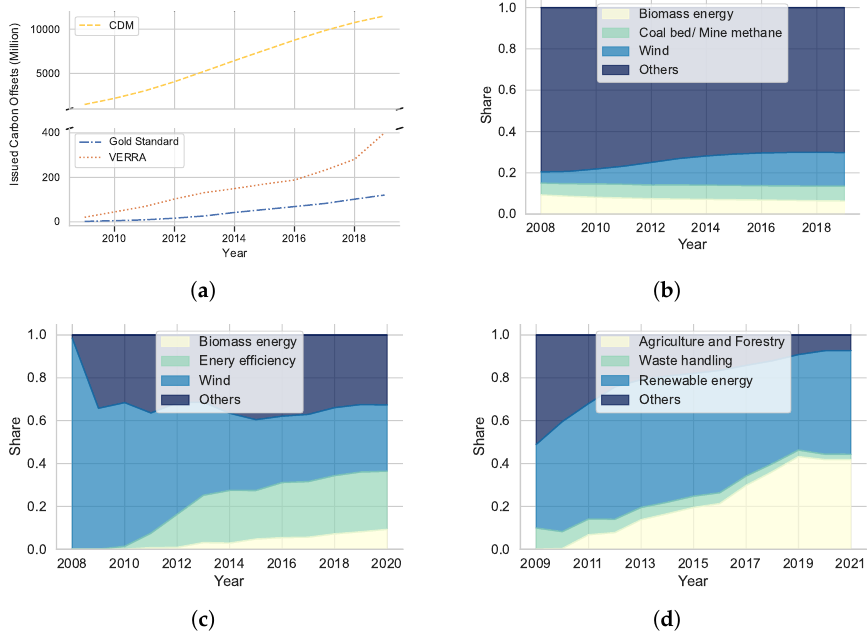
Figure 3. Supply of carbon verification standards programs and share of offset types by program. Notes: Panel ( a ) shows the cumulative issued carbon offsets of the CDM, Gold Standard, and VERRA over time. Panels ( b – d ) show the time-varying share of carbon offset projects types for cumulative issued carbon offsets of the CDM, Gold Standard, and VERRA. Source: Own